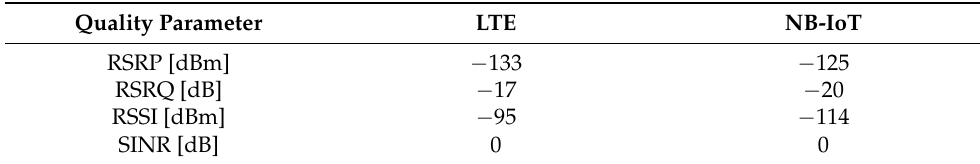
Table 3. Found thresholds for the ML algorithm. Quality Parameter LTE NB-IoT RSRP [dBm] − 133 RSRQ